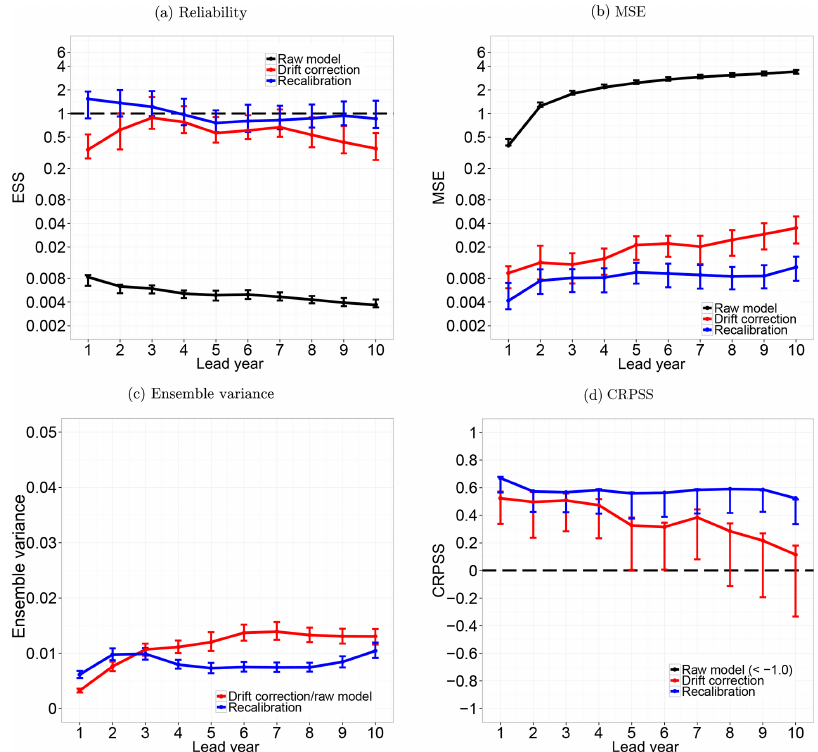
Figure 8. Reliability (a) , MSE (b) , ensemble variance (c) and CRPSS (d) of global mean surface temperature without any correction (black line), after drift correction (red line) and recalibration with DeFoReSt (blue line). The CRPSS for the raw forecasts (black line) is smaller than − 1 and therefore not shown. As the drift correction method does not account for the ensemble spread, the ensemble variance of the raw model and the drift-corrected forecast is equal. The vertical bars show the 95% confidence interval due to 1000-wise